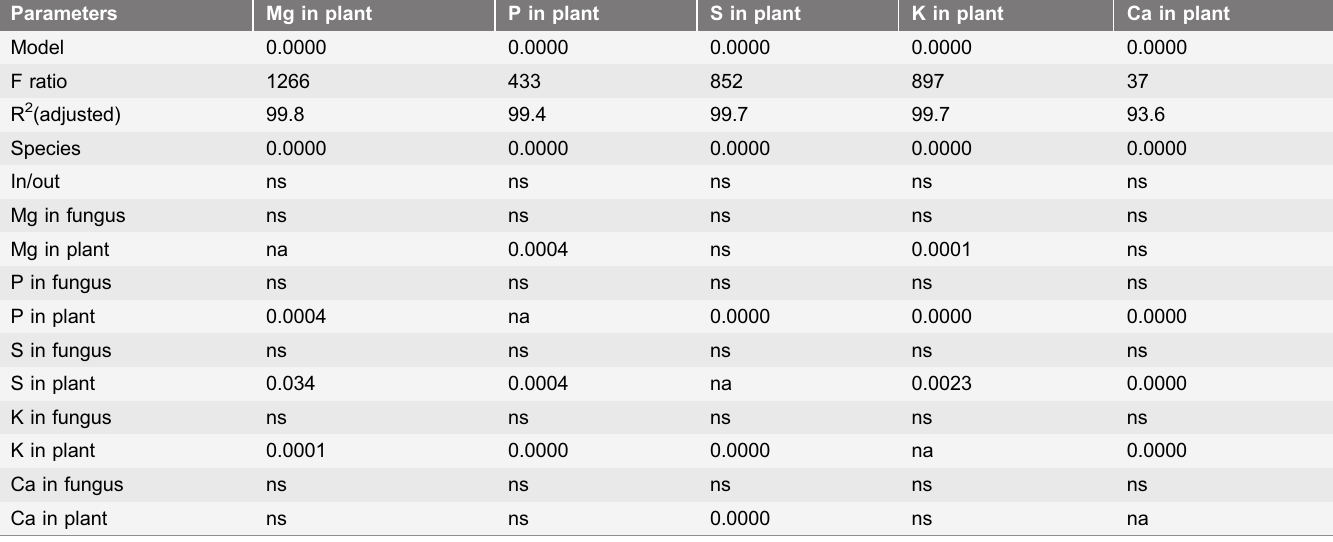
Table 2. Overview on the results of General linear Models for relative nutrient element concentrations in plant cells and cell walls.